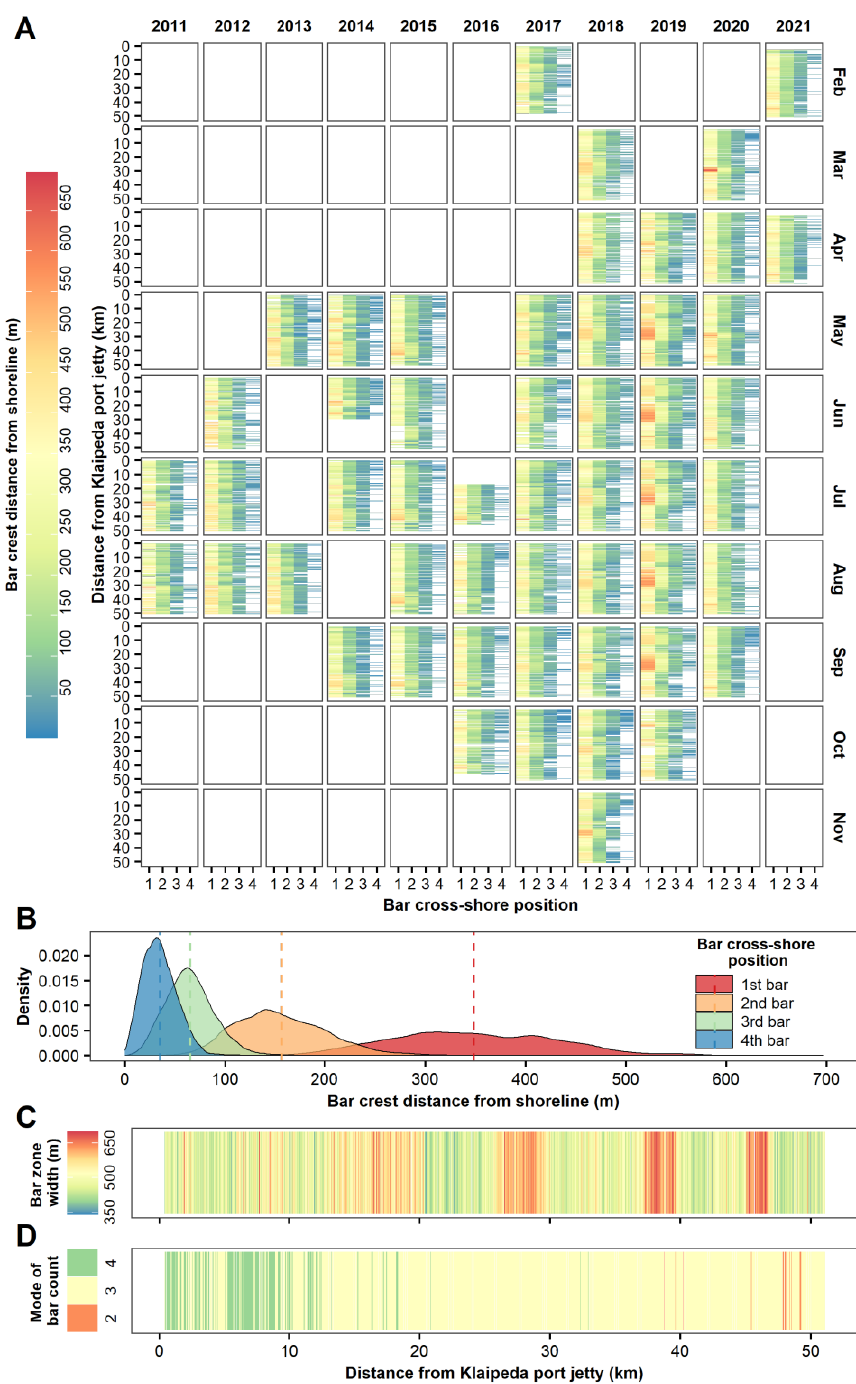
Figure 5. Morphological characteristics of the multi-bar system in the Curonian Spit: ( A ) alongshore variations in monthly bar distances from the shoreline by bar cross-shore position; ( B ) distribution of bar distances from the shoreline by bar cross-shore position; ( C ) alongshore variations in bar zone widths; ( D ) alongshore variations in bar count mode.